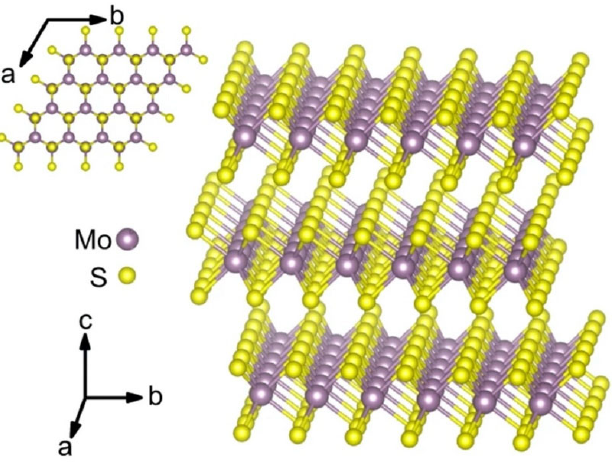
Figure 11. Atomic structure of a single layer of transition metal dichalcogenides (TMD). Reprint with permission from reference [217]. Copyright 2021 Springer Nature.